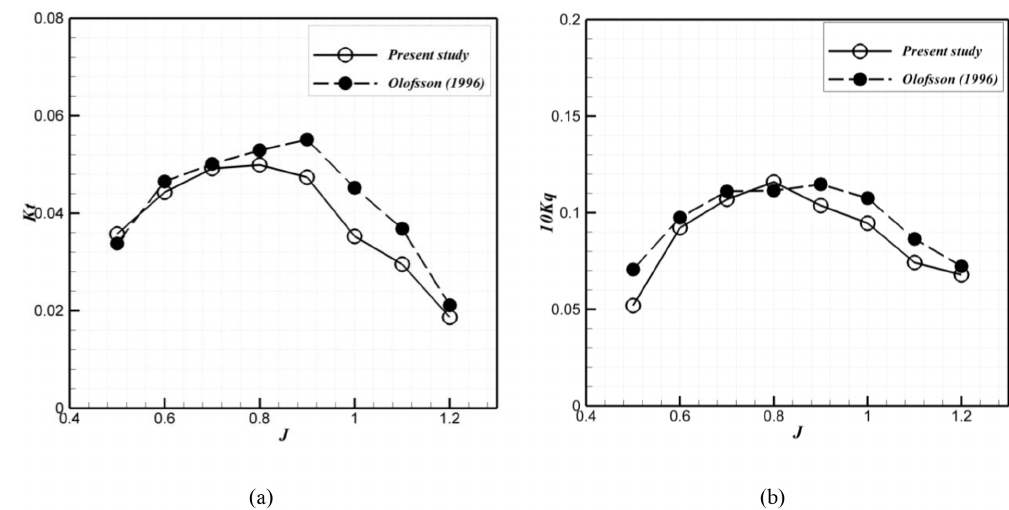
Figure 9. Comparison of the coefficient of thrust (a) and torque (b) with those obtained by Olofsson at Fr = 2 (1996).